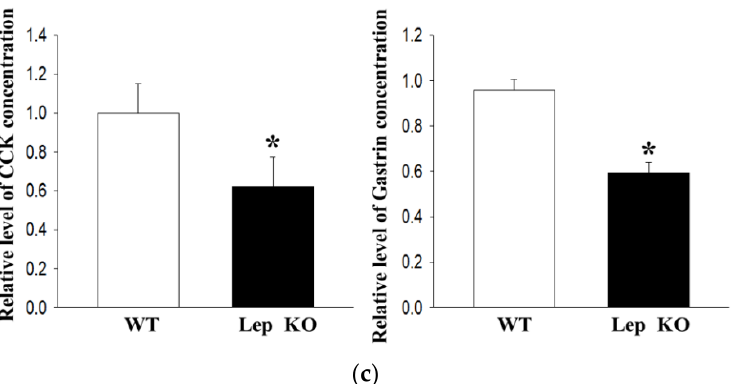
Figure 7. Expression of C-kit and PGP9.5, phosphorylation of MLC, and serum concentration of GI hormones. ( a ) Expression levels of C-kit and PGP9.5 were measured by Western blot analysis using specific primary antibodies and HRP-labeled anti-rabbit IgG antibody. Three to five mice per group were used to prepare the total tissue homogenate, and Western blot analyses were assayed in duplicate in each sample; ( b ) Expression levels of MLC and p-MLC were measured by Western blot analysis using the specific primary antibodies and HRP-labeled anti-rabbit IgG antibody. After determining the intensity of each band using an imaging densitometer, the relative levels of the four proteins were calculated based on the intensity of actin. Three to five mice per group were used to prepare the total tissue homogenate, and Western blot analyses were assayed in duplicate in each sample; ( c ) The concentrations of CCK and gastrin were measured in the transverse colon homogenate by an enzyme-linked immunosorbent assay. The minimum detectable concentration of each kit was 0.1–1000 pg / mL of CCK and 0.312–20 pg / mL of gastrin. Three to five mice per group were used to prepare the tissue homogenate, and the hormone level was assayed in duplicate in each sample. The data are reported as the mean ± SD. *, p < 0.05 compared to the WT group. Abbreviations: WT, Wild